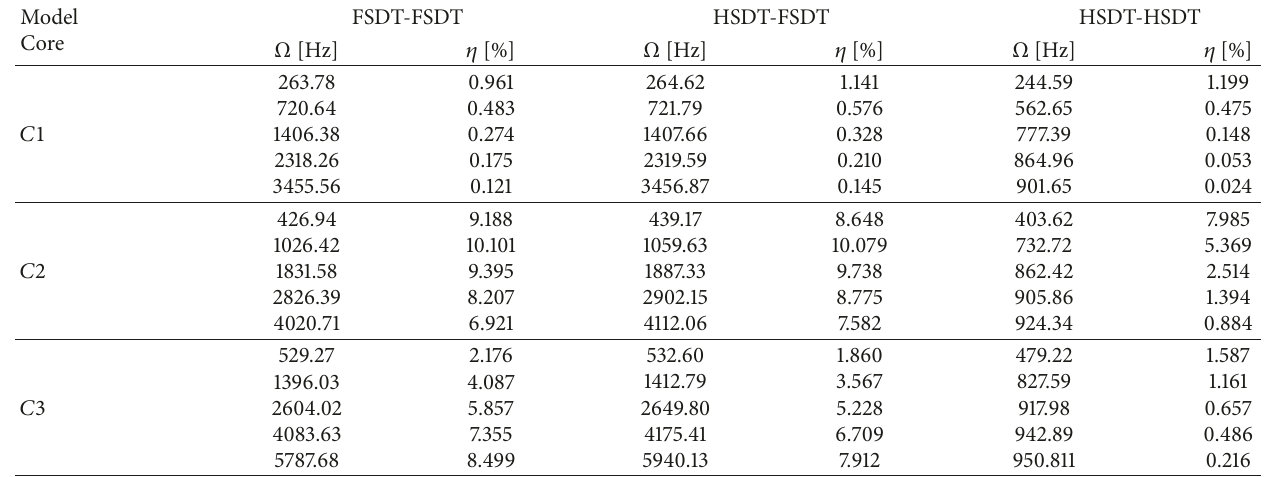
Table 11: Frequencies Ω and loss factors 𝜂 . Magnesium